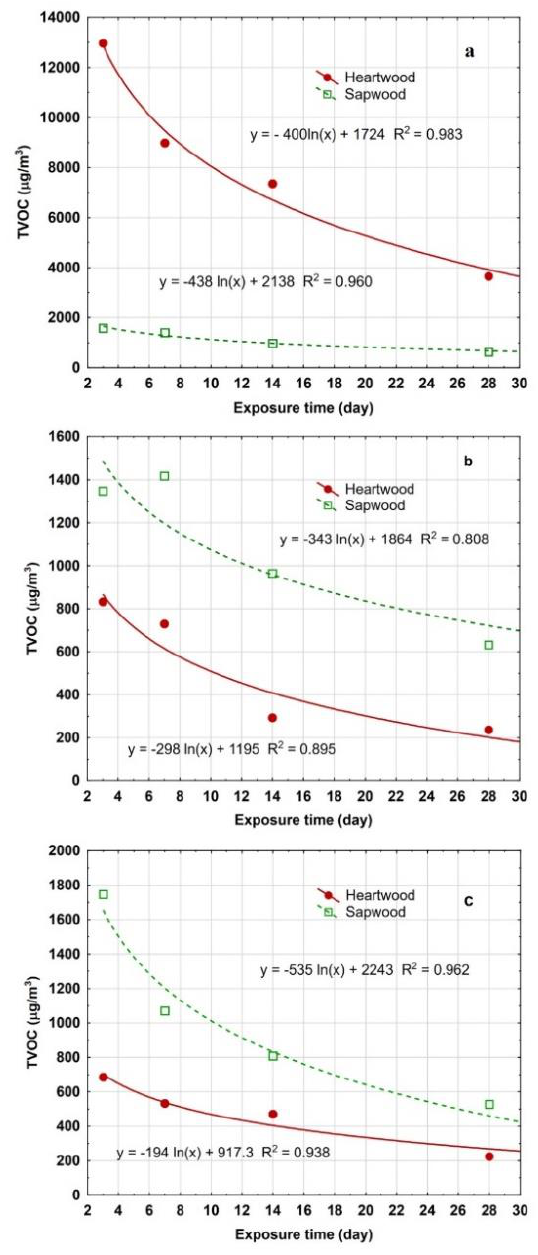
Figure 1. Total volatile organic compound (TVOC) concentration for heartwood and sapwood of ( a ) Scots pine ( Pinus sylvestris L.); ( b ) European larch ( Larix decidua Mill.) and ( c ) Norway spruce ( Picea abies (L.) Karst.) after 3, 7, 14 and 28 days of exposure in the test chamber.